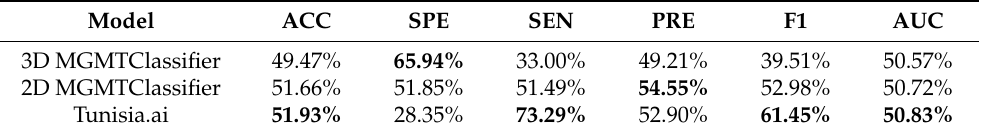
Table 4. 5-fold CV performances of models trained on dataset B and tested on dataset A . The input sequence is KBF for both the 3D and 2D MGMTClassifier models and T1-w CE for the Tunisia.ai one.For each metric, the best value is reported in bold.